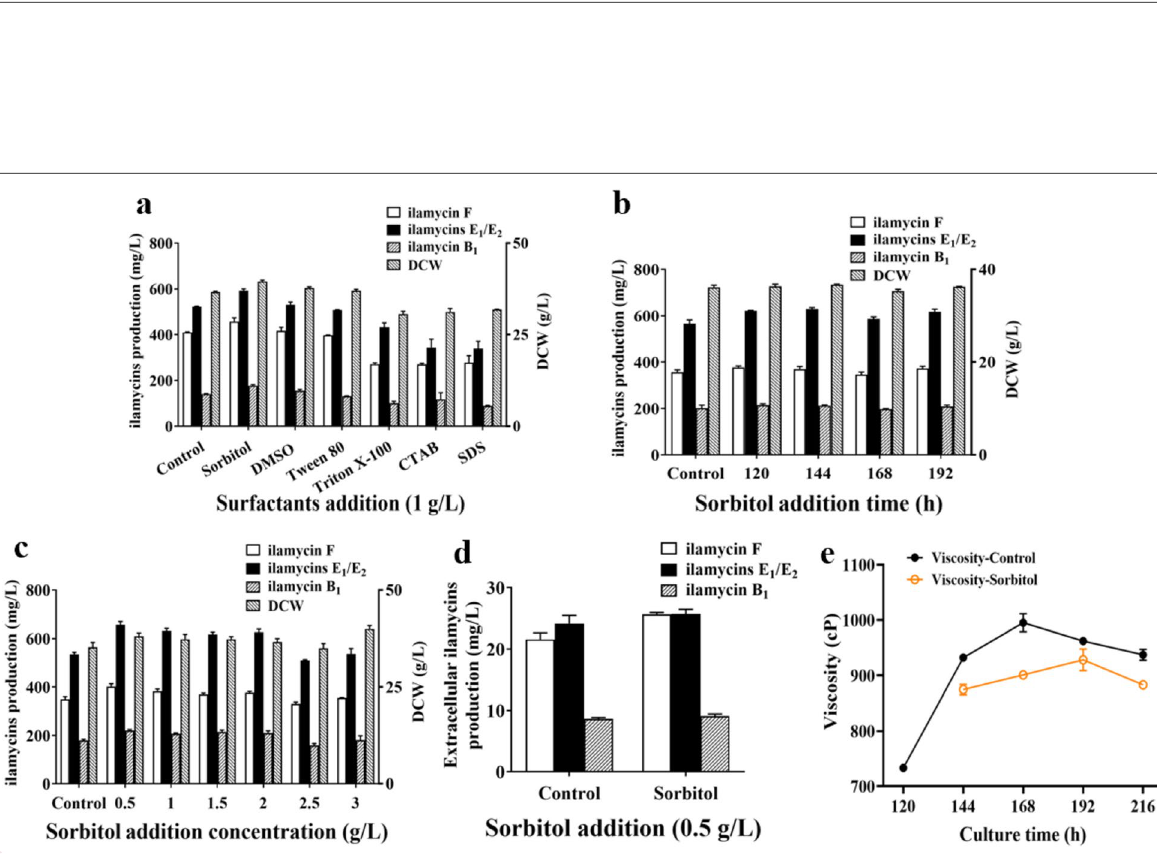
Fig. 8 Effect of surfactants addition ( a ), sorbitol addition time ( b ), sorbitol addition concentration ( c ) on DCW and ilamycins production, and effect of sorbitol addition on extracellular ilamycins production ( d ) and viscosity ( e